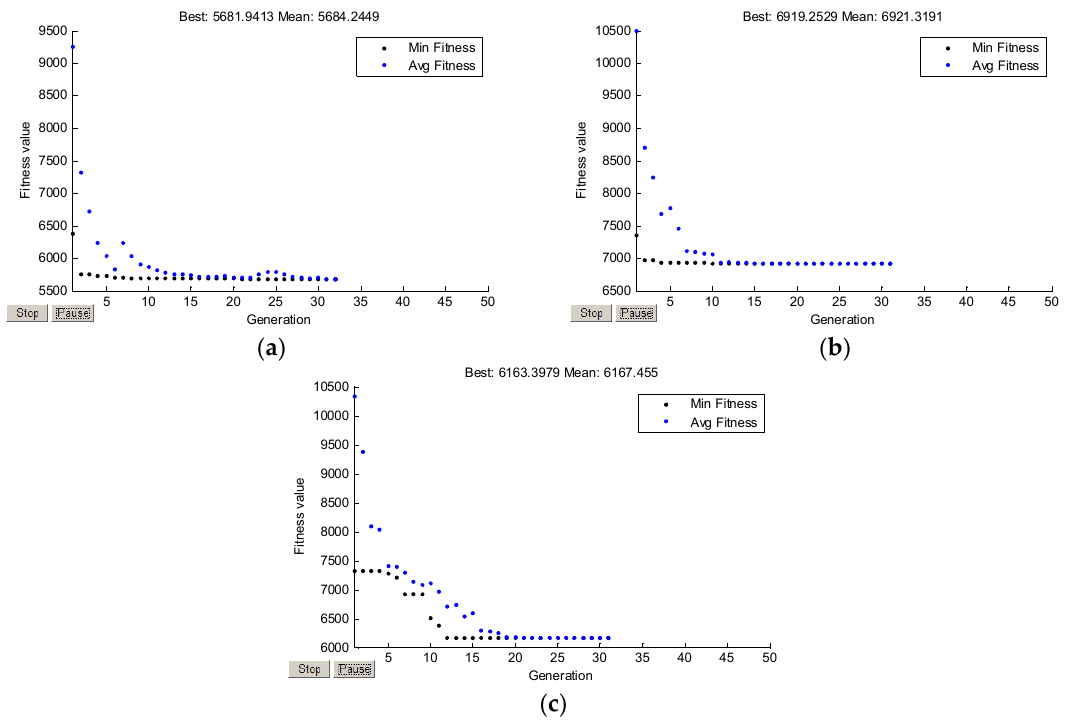
Figure 7. Fitness functions in the case of the three operating regimes : ( a ) DRY; ( b ) RAIN; ( c ) STORM.